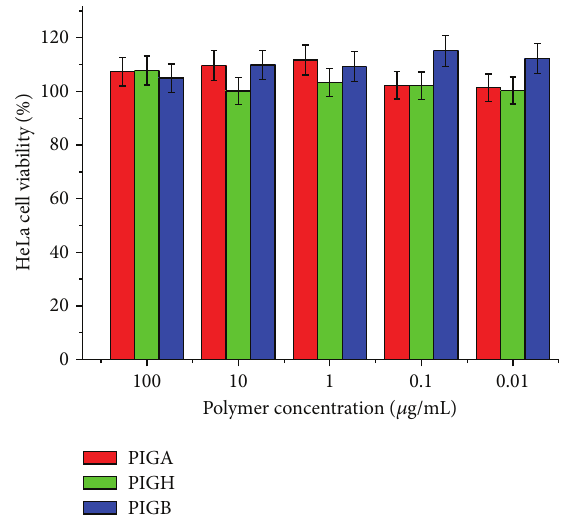
Figure 7: Viability of HeLa cells in different polymers solution over 48 h